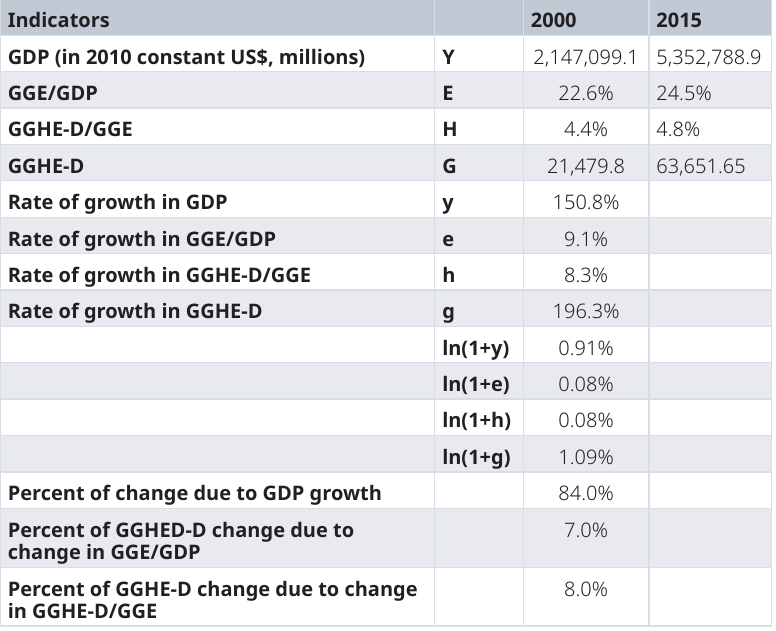
Table 5. Illustration of GGHE-D decomposition for low-income countries.